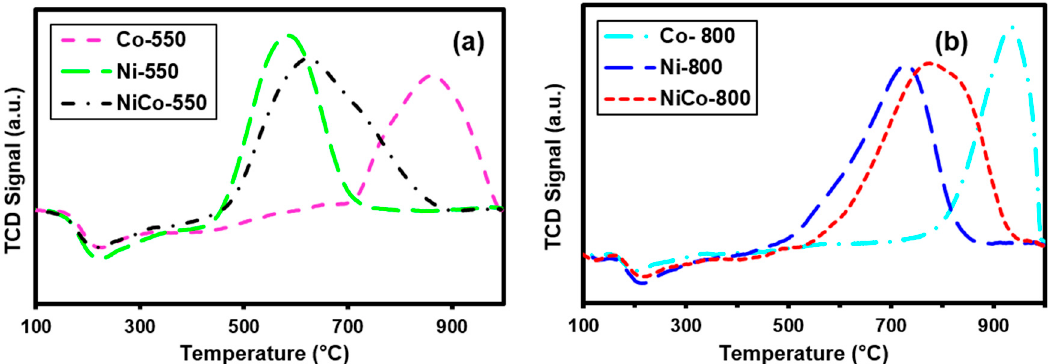
Figure 3. TPR profiles for fresh monometallic Ni or Co and bimetallic Ni–Co-based catalysts ( a ) calcined at 550 °C and ( b ) calcined at 800 °C. at 550 ◦ C and ( b ) calcined at 800 ◦